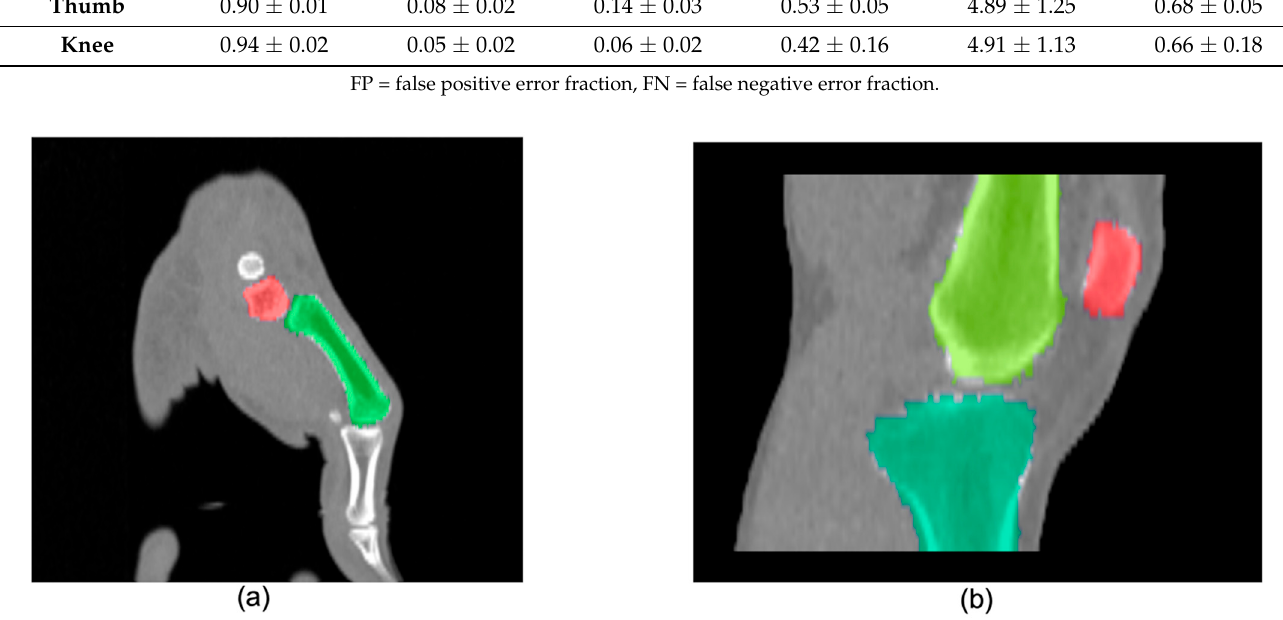
Figure 5. Segmentation result of our multi-atlas multi-label segmentation for ( a ) thumb base and ( b ) knee joint.